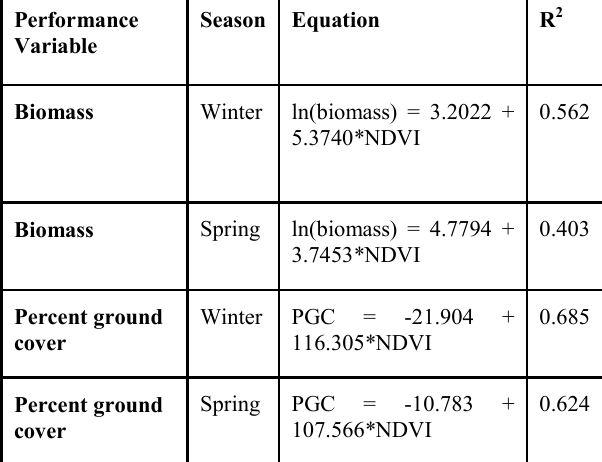
Table 2. Calibration models to predict biomass and percent vegetative ground cover from satellite-derived NDVI (adapted from Thieme et al., submitted